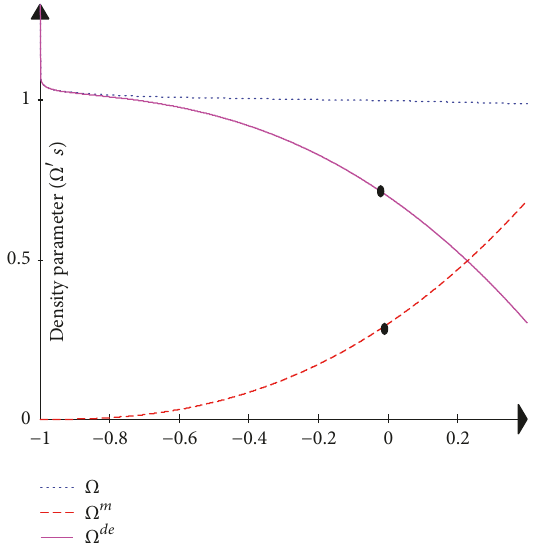
1, 𝛽 = 0.01 , Ω 𝑚 = 0.3, 𝜔 𝑚 = 0 𝜔 = 2 , 𝐾 = 0.01 , and 𝜎 = 0